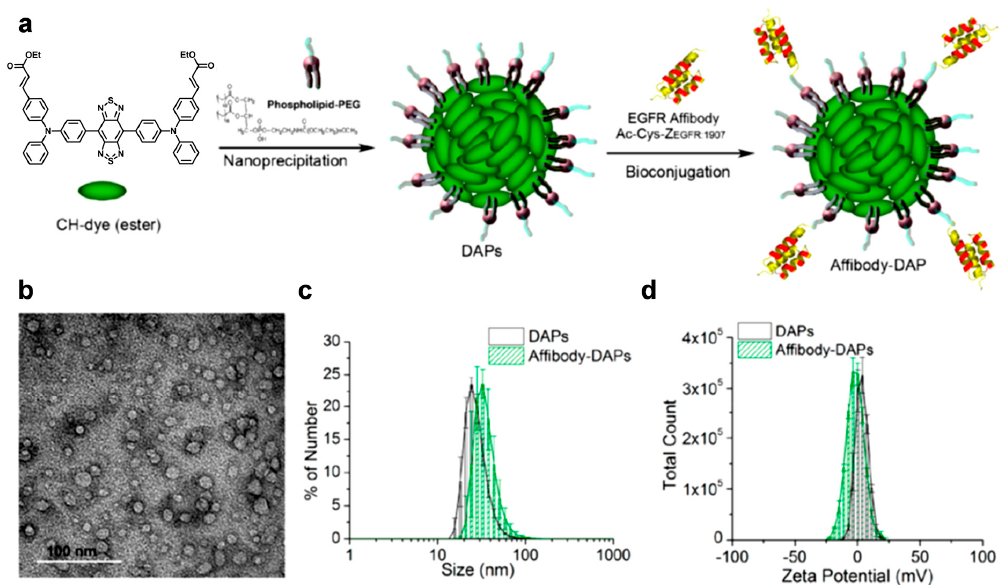
Figure 18. ( a ) Schematic illustration of preparation of a ffi body − DAPs. The DAPs were prepared through nanoprecipitation of CH1000. The CH1000 molecules are represented as light green ovals. The phospholipid (DSPE-PEG-5000) has two hydrophobic tails and one hydrophilic PEG chain, and is illustrated as a purple ball with two dark gray tails and one light gray head. EGFR affibodies (Ac-Cys-ZEGFR:1907, three α -helices) were immobilized on the surface of DAPs via a bifunctional cross-linker. ( b ) Representative TEM image of negatively stained DAPs. Scale bar = 100 nm. ( c ) Hydrodynamic sizes of DAPs (black line and column) and a ffi body − DAPs (green line and column). ( d ) Zeta potentials of DAPs and a ffi body − DAPs. Reprinted with permission from [100]. Copyright, American Chemical Society (2017).